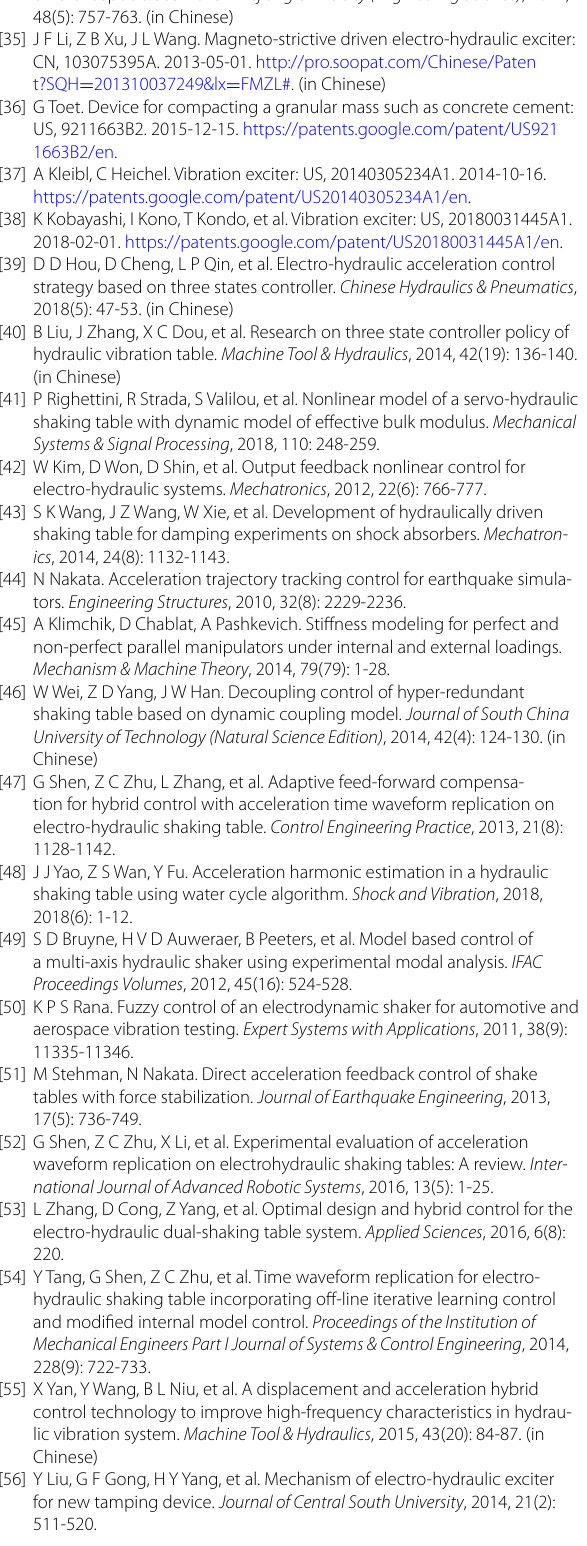
hydraulic vibration table. Machine Tool & Hydraulics , 2014, 42(19): 136-140. (in Chinese) [41] P Righettini, R Strada, S Valilou, et al. Nonlinear model of a servo-hydraulic shaking table with dynamic model of effective bulk modulus. Mechanical Systems & Signal Processing , 2018, 110: 248-259. [42] W Kim, D Won, D Shin, et al. Output feedback nonlinear control for electro-hydraulic systems. Mechatronics , 2012, 22(6): 766-777. [43] S K Wang, J Z Wang, W Xie, et al. Development of hydraulically driven shaking table for damping experiments on shock absorbers. Mechatron- ics , 2014, 24(8): 1132-1143. [44] N Nakata. Acceleration trajectory tracking control for earthquake simula- tors. Engineering Structures , 2010, 32(8): 2229-2236. [45] A Klimchik, D Chablat, A Pashkevich. Stiffness modeling for perfect and non-perfect parallel manipulators under internal and external loadings. Mechanism & Machine Theory , 2014, 79(79): 1-28. [46] W Wei, Z D Yang, J W Han. Decoupling control of hyper-redundant shaking table based on dynamic coupling model. Journal of South China University of Technology (Natural Science Edition) , 2014, 42(4): 124-130. (in Chinese) [47] G Shen, Z C Zhu, L Zhang, et al. Adaptive feed-forward compensa- tion for hybrid control with acceleration time waveform replication on electro-hydraulic shaking table. Control Engineering Practice , 2013, 21(8): 1128-1142. [48] J J Yao, Z S Wan, Y Fu. Acceleration harmonic estimation in a hydraulic shaking table using water cycle algorithm. Shock and Vibration , 2018, 2018(6): 1-12. [49] S D Bruyne, H V D Auweraer, B Peeters, et al. Model based control of a multi-axis hydraulic shaker using experimental modal analysis. IFAC Proceedings Volumes , 2012, 45(16): 524-528. [50] K P S Rana. Fuzzy control of an electrodynamic shaker for automotive and aerospace vibration testing. Expert Systems with Applications , 2011, 38(9):